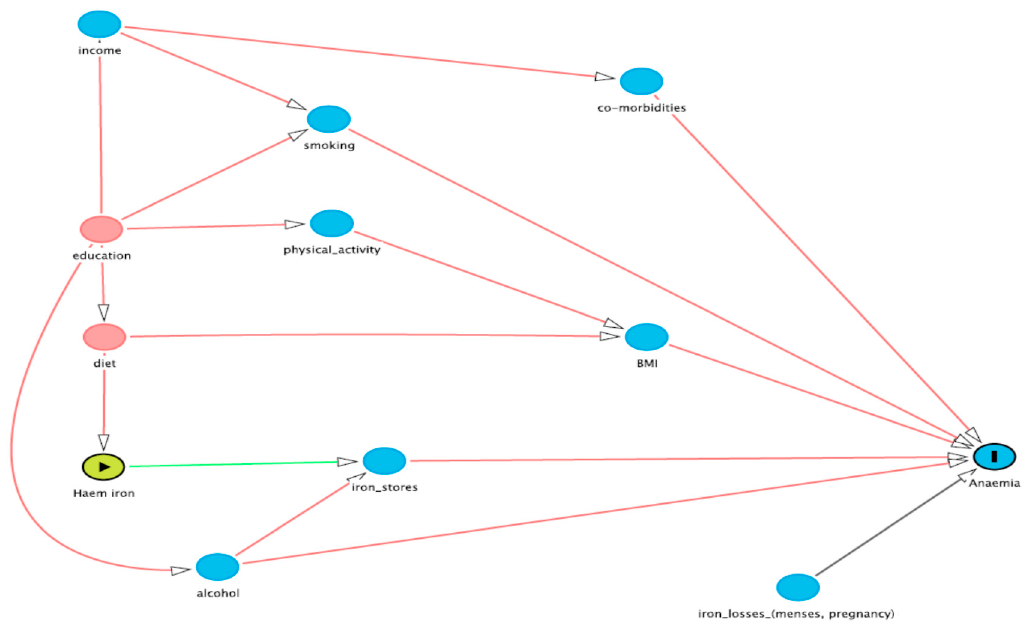
Figure 1. Directed Acyclic Graph (DAG) for the identification of potential confounders. The exposure of interest is haem iron and the outcome of interest is self-reported diagnosed anaemia. The directed acyclic graph makes explicit the causative model we are testing and the relationship of the co-variates. In order to identify confounders, the arrows coming out of haem iron are removed, since these are causative, and any “back door” paths that remain between haem iron and anaemia are identified. The back door paths need not follow the direction of the arrows. Adjusting for a co-variate “closes” the back door path, i.e., removes confounding, assuming that the co-variate is measured without error. A back door path is considered already closed if it passes through a “collider”, i.e., a node with 2 arrows pointing into it. Adjusting for a collider re-opens that path and increases the potential confounding.